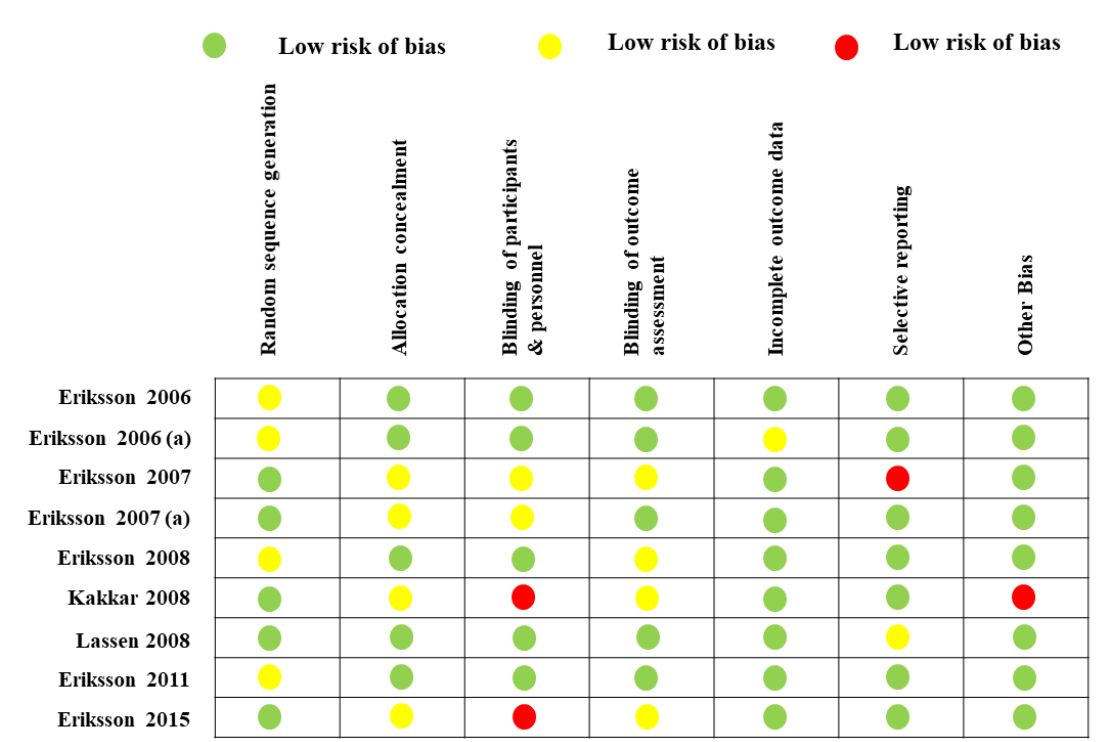
Figure 5. Risk of bias in the included studies.